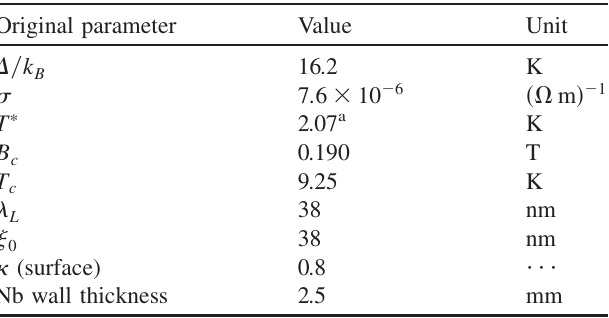
TABLE II. Fixed original and derived parameters used by (cid:6) 2 minimization of the collective data.